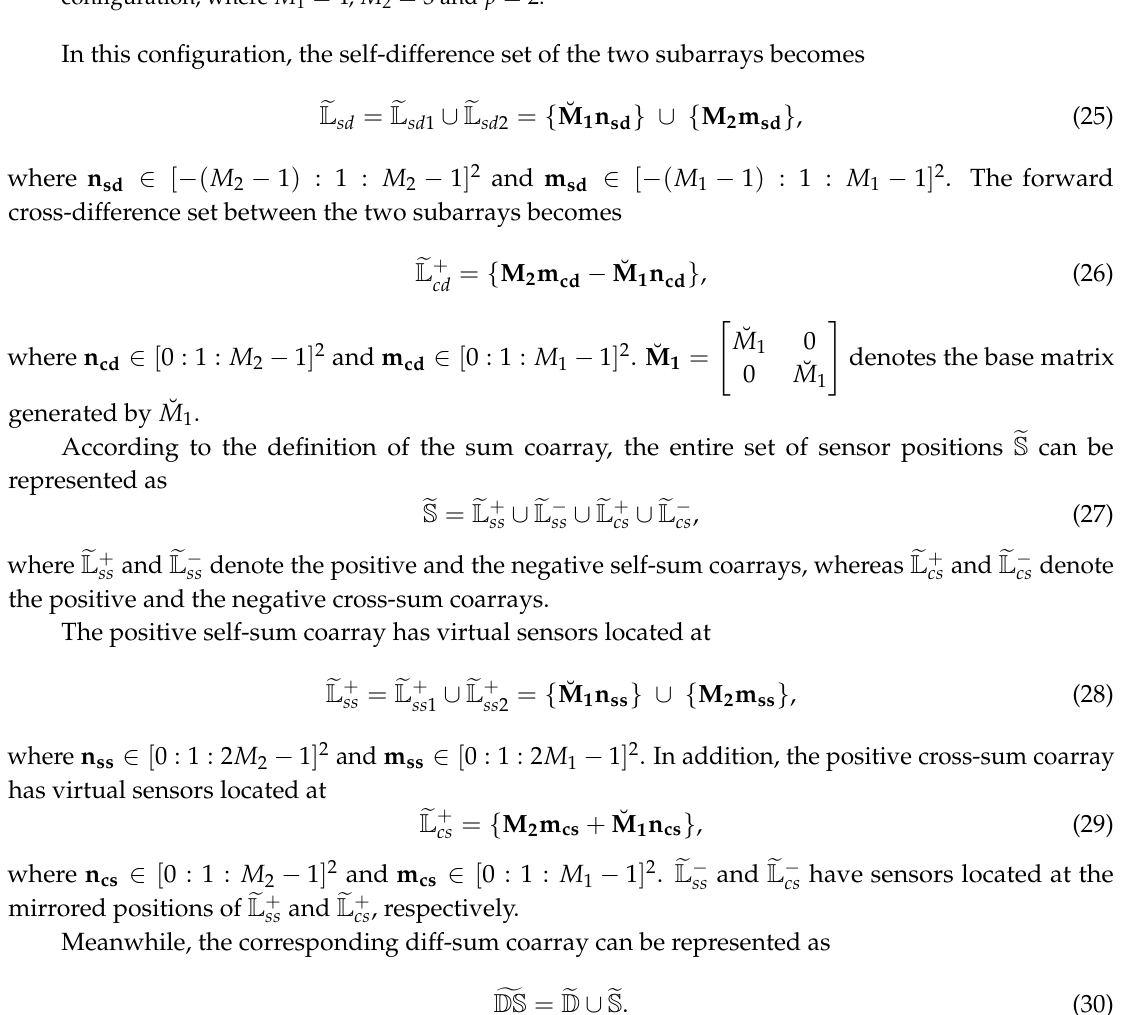
Figure 3. The compression process of a coprime array with a compressed subarray (CAACS) configuration, where M 1 = 4, M 2 = 3 and p =